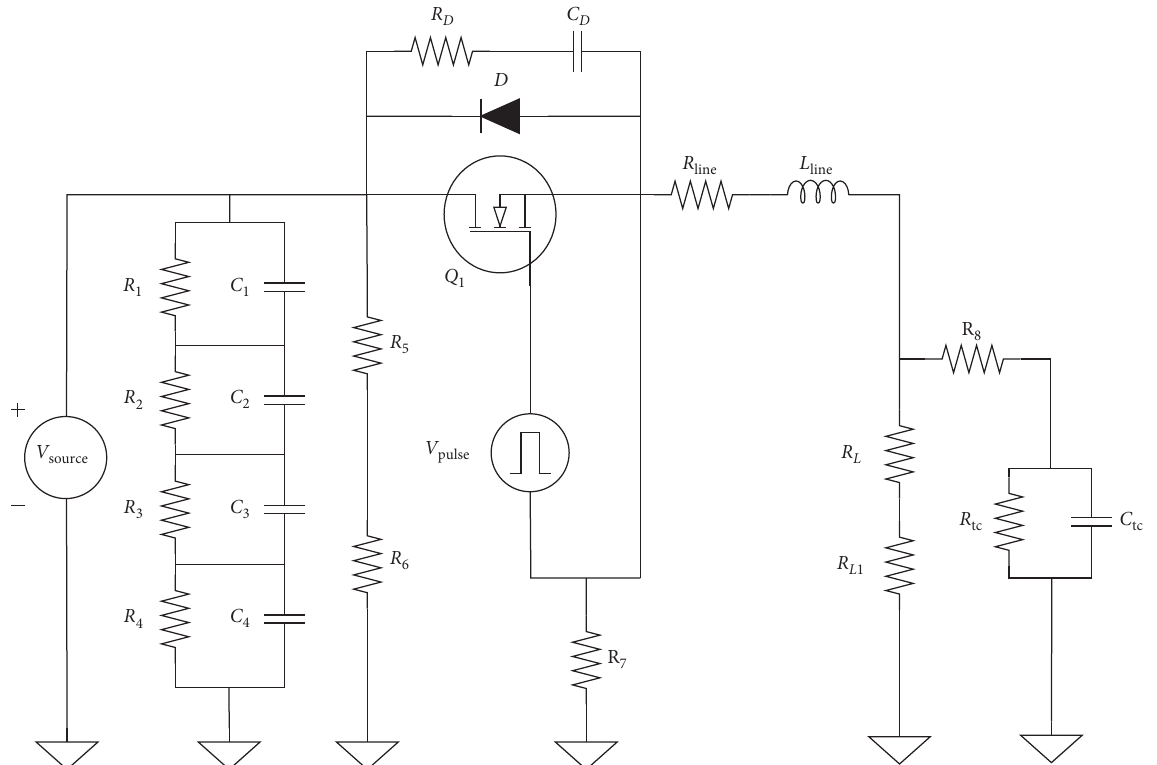
Figure 1: The proposed circuit implementing the capacitor-discharge technique to generate square-wave pulse. Table 1: Summary of the SPICE model parameters. Spice parameter Value